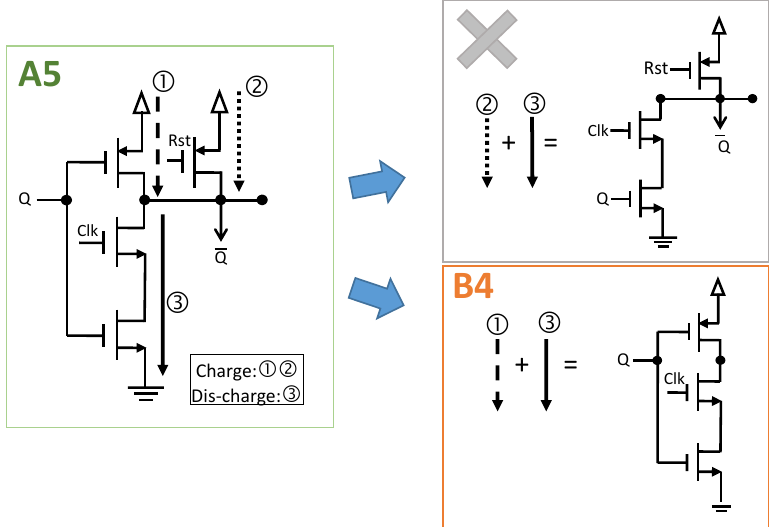
Figure 7. Illustration of current path method.